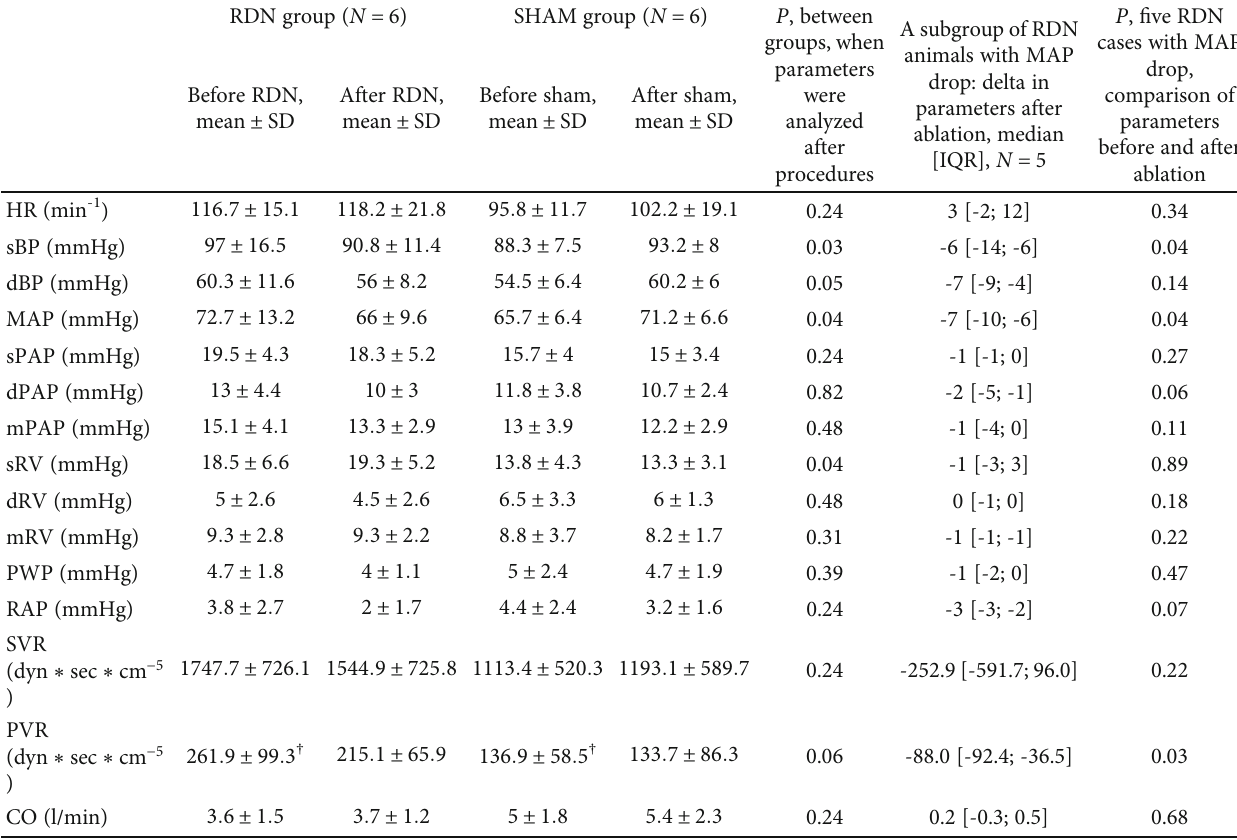
Table 2: Hemodynamic changes in the RDN and SHAM groups. RDN group ( N = 6 ) SHAM group ( N = 6 ) Before sham, After